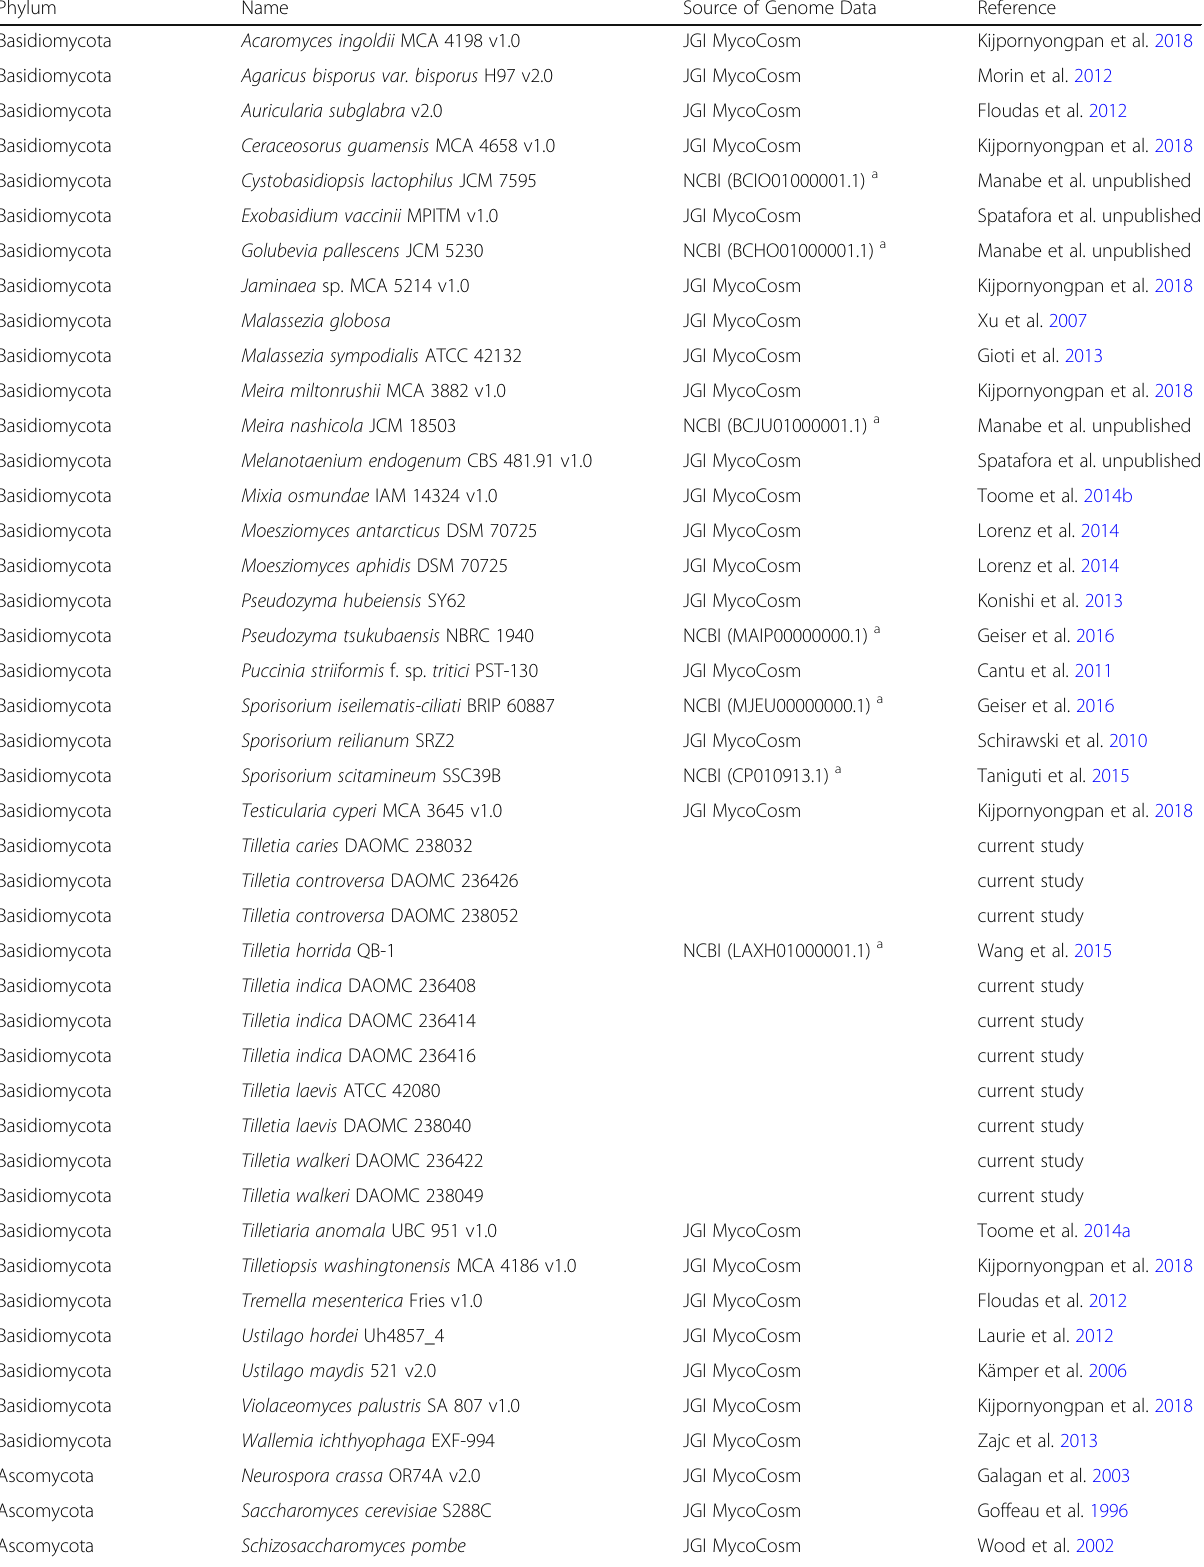
Table 2 List of genomes used for phylogenetic analysis in current study